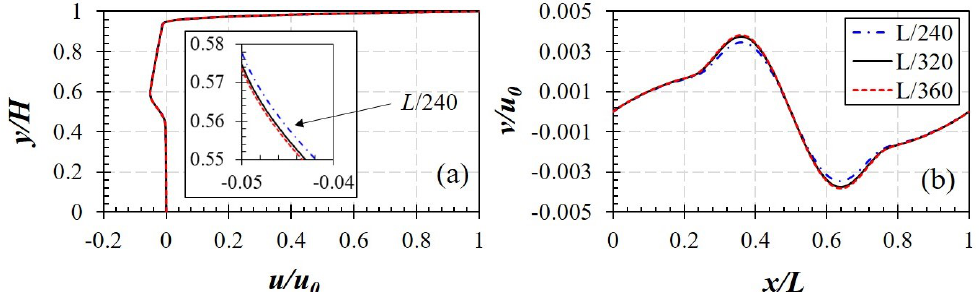
Figure 5. Influence of mesh refinement on velocity distribution: ( a ) x -velocity along the vertical centerline and ( b ) y -velocity along the horizontal centerline of a square cavity at Od = 10 .